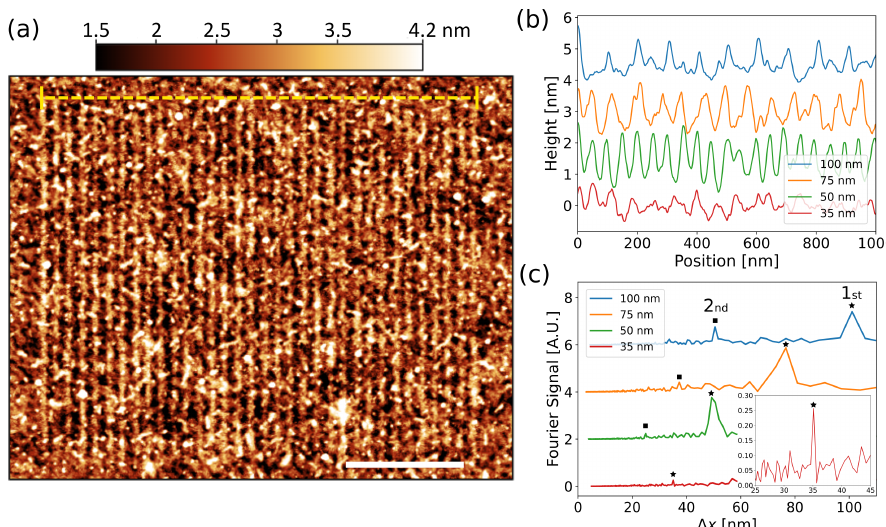
Figure 2. ( a ) Example of topographic height map for Set 1 irradiated with a 50 nm pattern. The pat- terned area is highlighted by the yellow dashed line. The scale bar is 500 nm. ( b ) Comparison of lines extracted from AFM scans of patterns with different pitches, as reported in the legend. Each line average is shifted 1.5 nm. ( c ) Fast Fourier transform of the lines reported in ( b ). First harmonic peaks are indicated as “1st” and by stars, second harmonic peaks as “2nd” and by squares. Inset is a zoomed-in image of the FFT of the height profile for p = 35